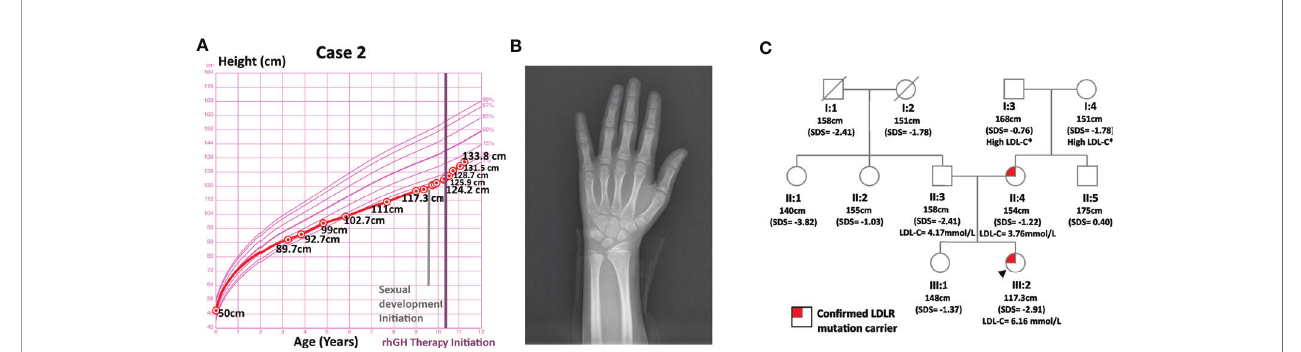
FIGURE 2 | Information on case 2. (A) Growth curve. (B) Plain X-ray of left hand and wrist. (C)